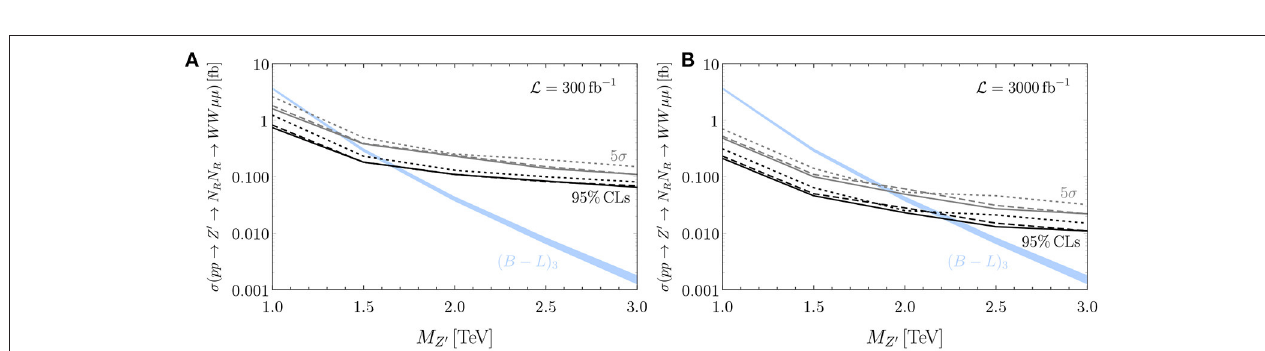
Z BL ℓ + ℓ − as a function of for various representative values of g BL at NLO+NLL(thresh.) for √ s → → Z ′ NN as a function of M N for M Z 1,2,3 TeV, v S 8 TeV, with √ s 14 TeV and 100 TeV. → → = = ′ =